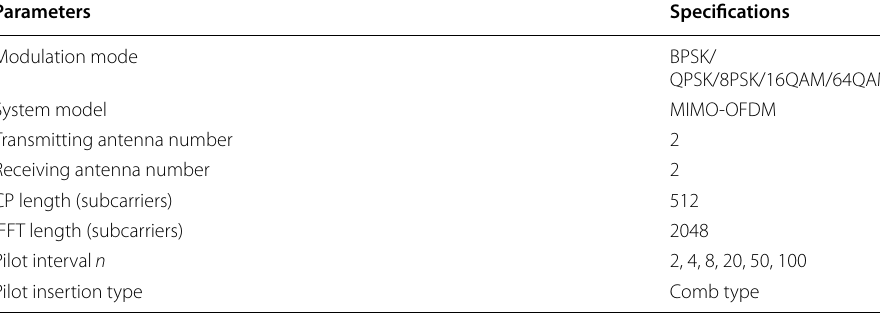
Table 2 Parameters of MIMO-OFDM system